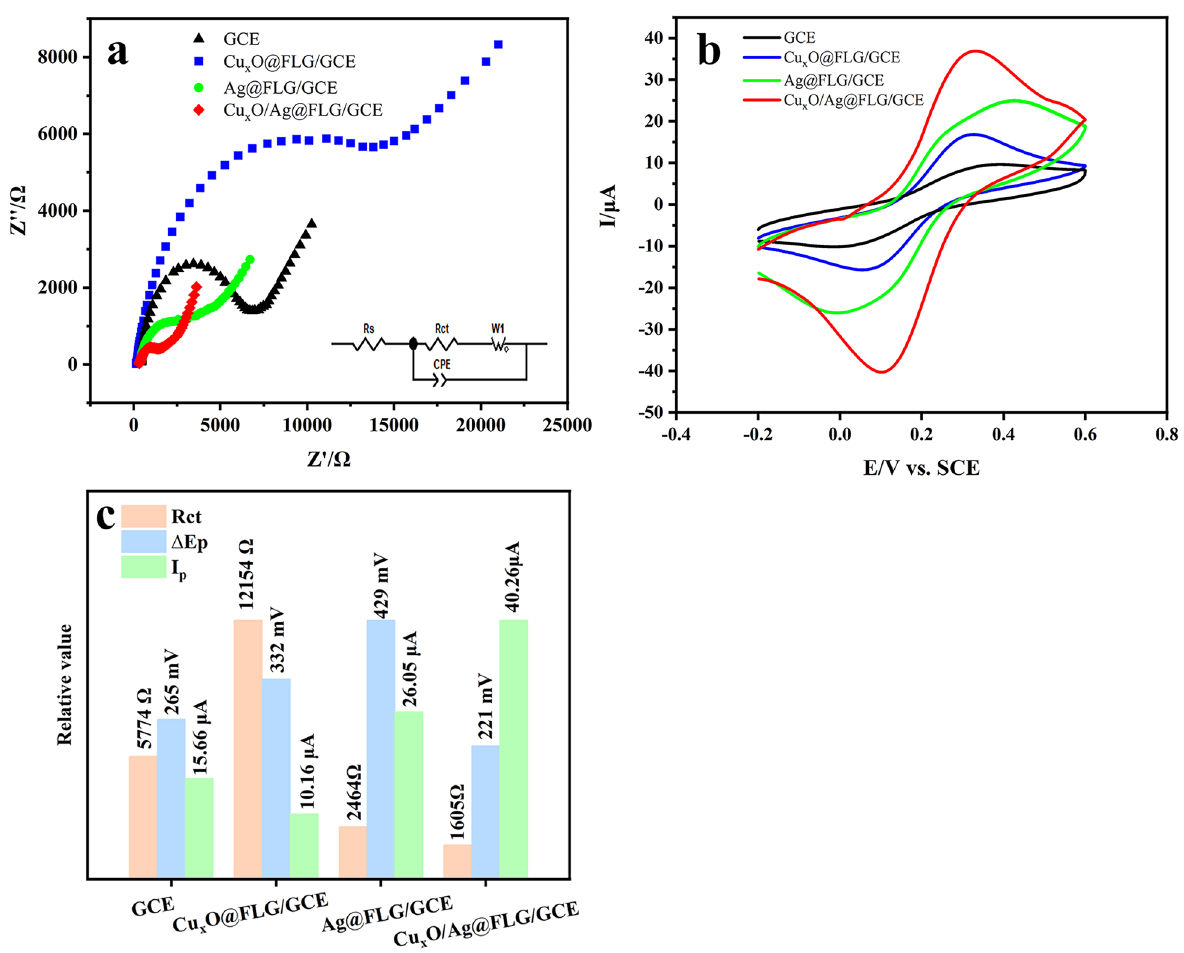
Figure 4. ( a ) EIS of bare GCE, Cu x O@FLG/GCE, Ag@FLG/GCE, Cu x O/Ag@FLG/GCE in 1 mM K 3 [Fe